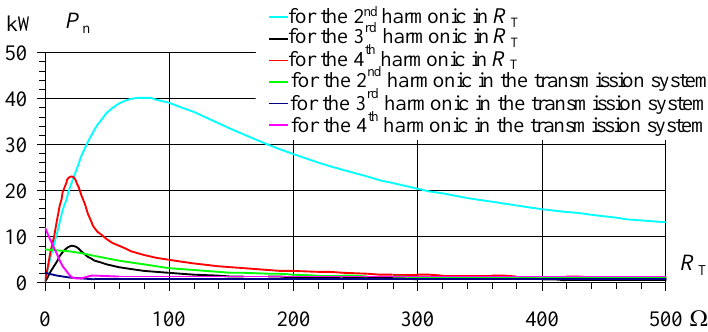
Figure 7. Active power of a higher harmonic discharged on the damping resistor R T and in the transmission system as a function of the resistance of the damping resistor R T .